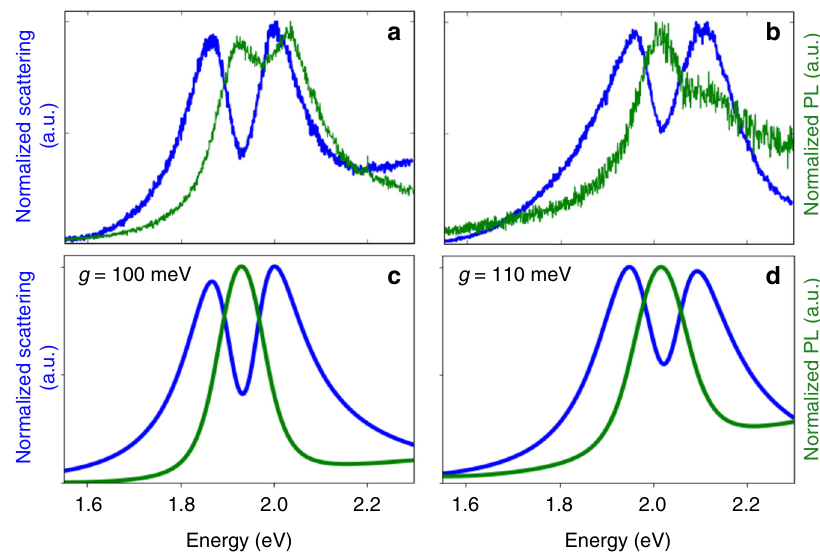
Fig. 4 Quantum-dot / gap-plasmon systems in the intermediate-coupling regime. a , b Measured scattering spectra (blue) and photoluminescence spectra (green) before ( a ) and after ( b ) intense laser illumination. c , d Corresponding theoretical scattering and photoluminescence